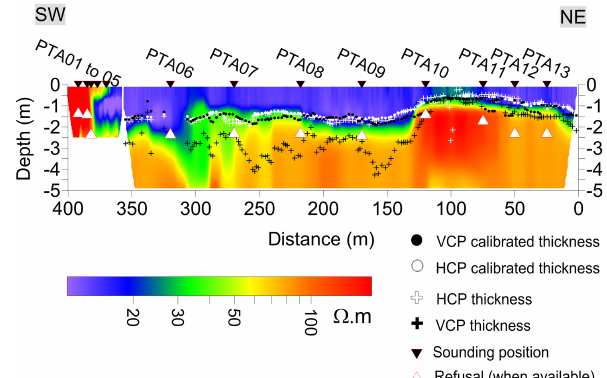
Figure 5. Results from the electrical resistivity imaging (ERI) inver- sion, computed along the reference profile. This section reveals the two main (conductive and resistive) geological units. The markers correspond to the inverted location of the interface (from EMI mea- surements) between the conductive unit and the substratum, before and after linear calibration (Fig. 6). This figure shows that calibra- tion of the raw VCP measurements leads to significant corrections in inverted depth, when compared to the calibration of the HCP